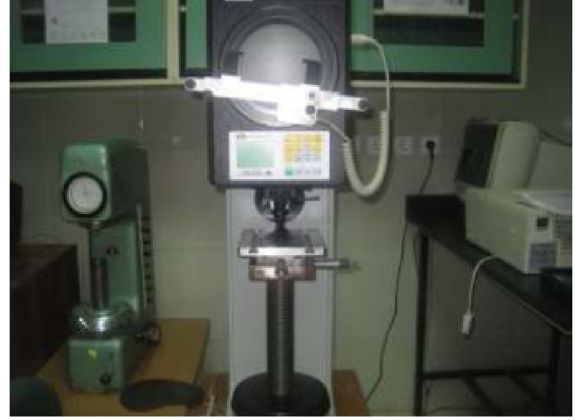
Fig. 2. (Color online) Instron hardness machine.